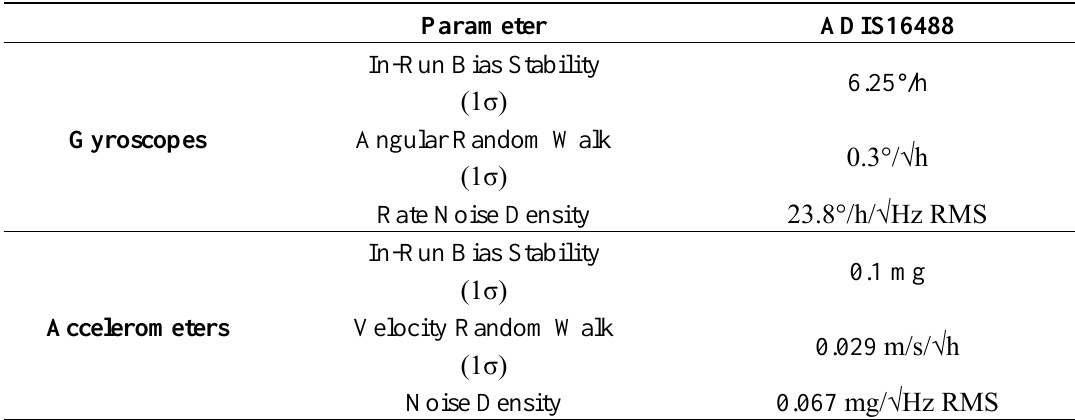
Table 1. IMU Specifications